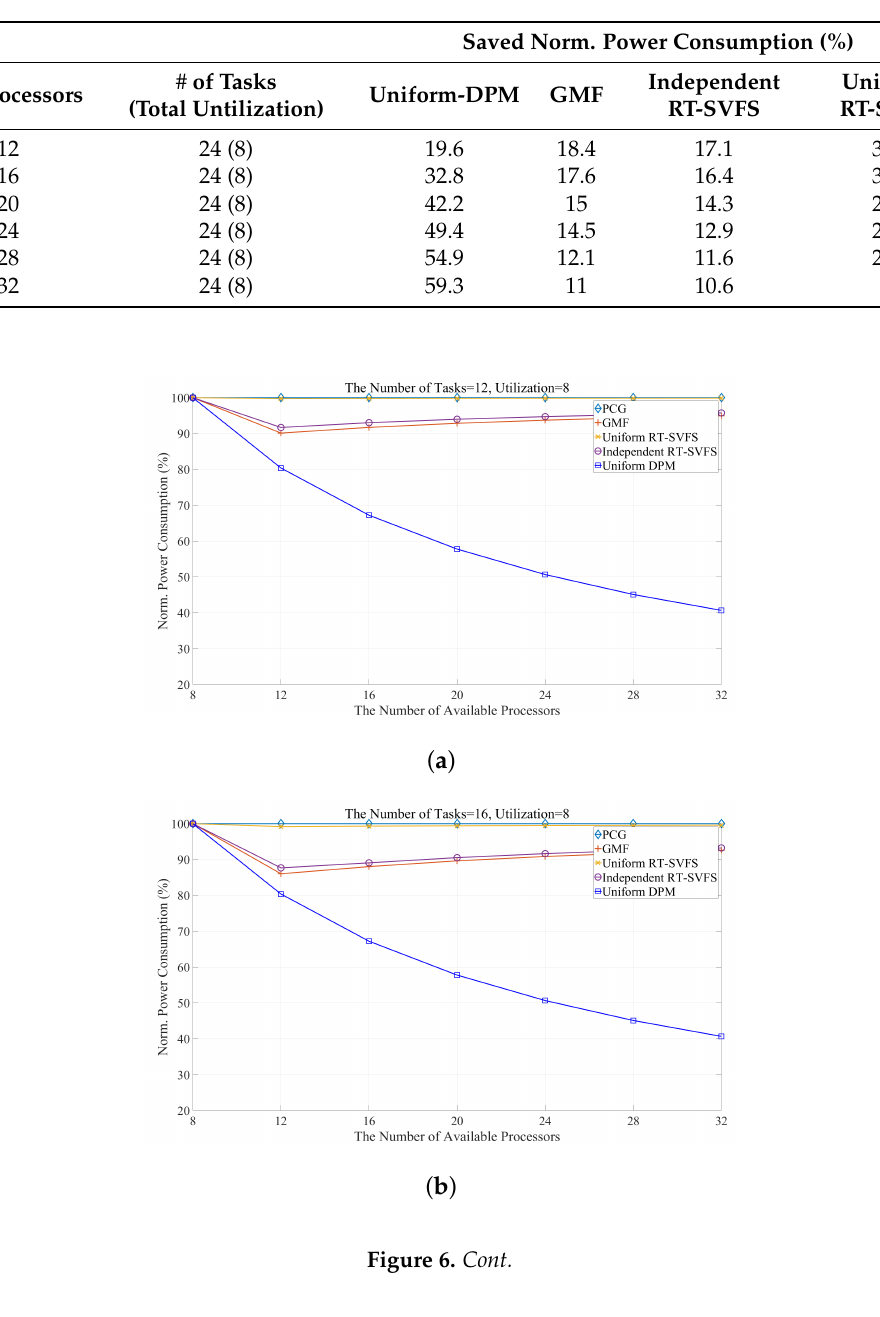
Table 15. Summary of the experimental results by varying the number of uniform